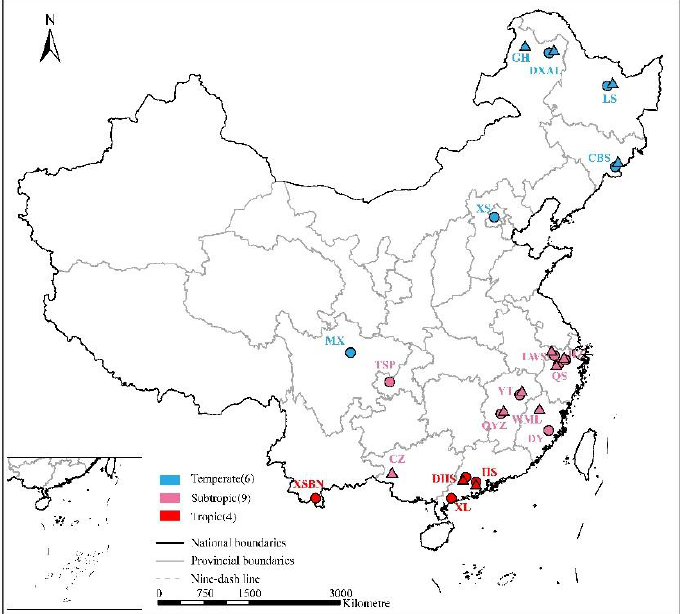
Figure 1. Locations of the studied forest sites across China (n = 19). Circles and triangles represent the studied sites of N 2 O and CH 4 , respectively.